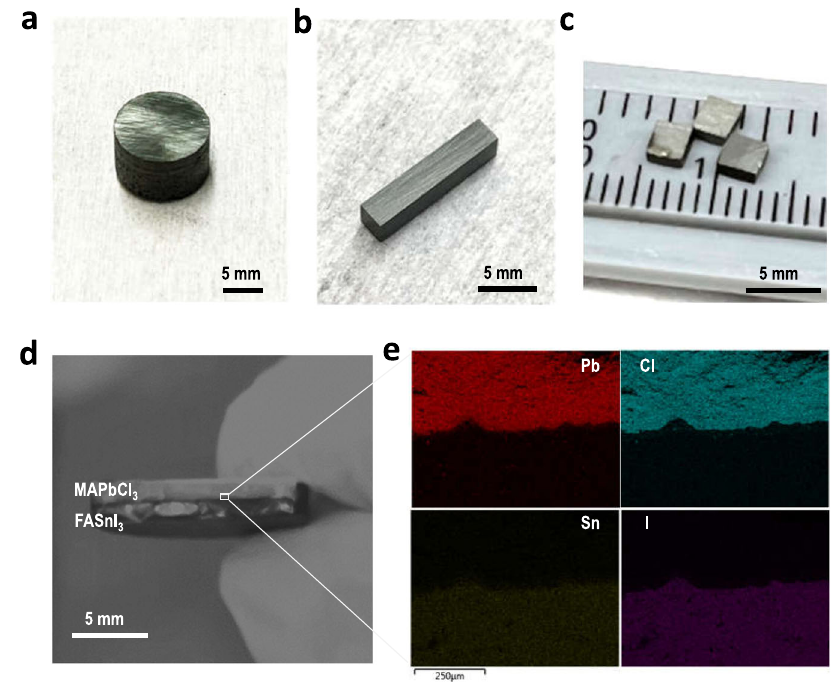
Fig. 5 | FAST-based additive printed samples of different con fi gurations. FAST- MAPbI 3 samples as a 5g column, b bar sample, and c cube samples. d Photo of